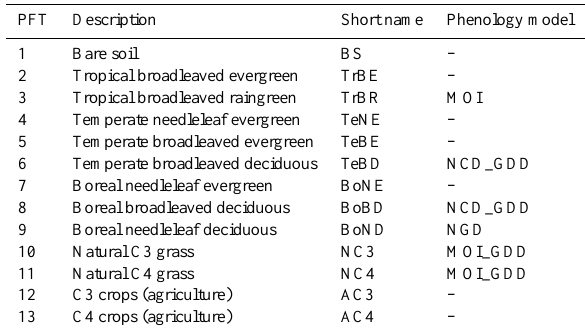
Table 1. Standard PFTs used in ORCHIDEE, their short name and corresponding phenology model (see Appendix A for a full descrip- tion of the phenology models). Evergreen and agriculture PFTs do not have a specific phenology model in the ORCHIDEE